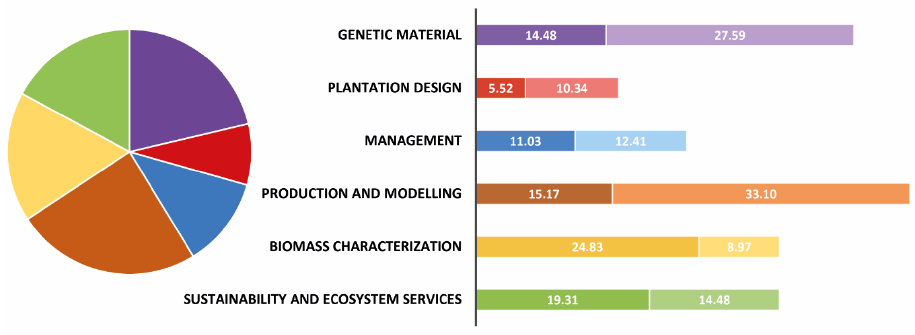
Figure 4. Percentages of Spanish publications in each of the six categories established. The light color corresponds to the gray literature on each subject.